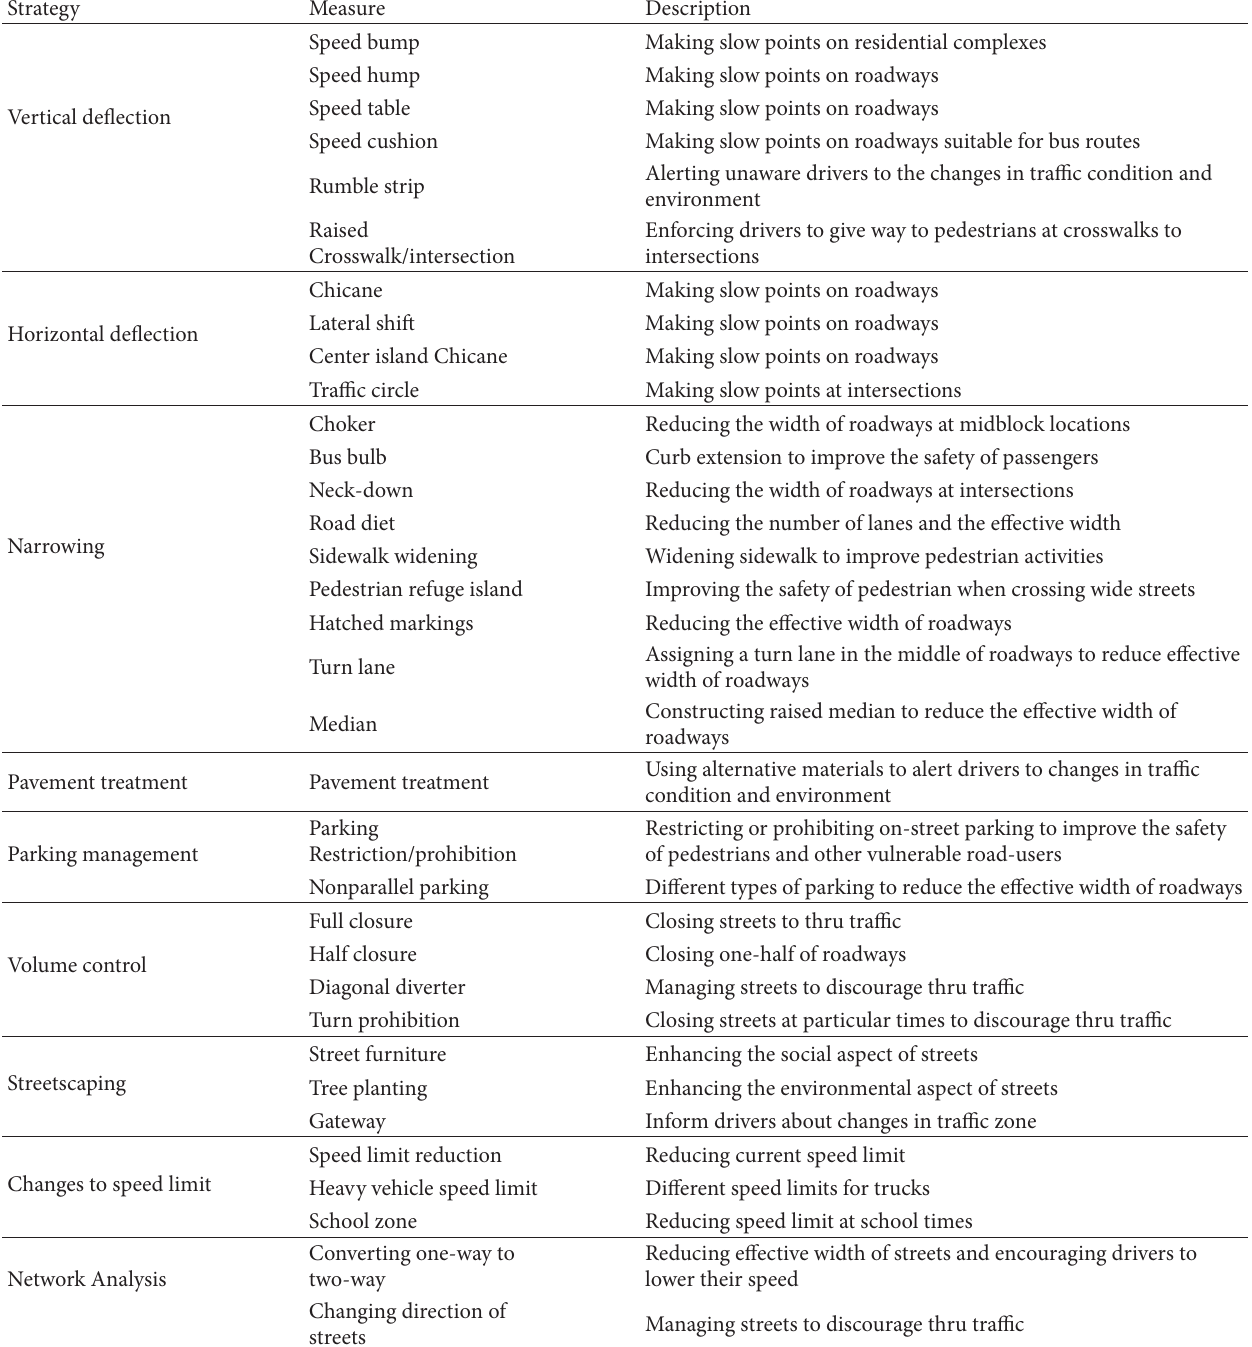
Table 6: A screenshot of the traffic calming strategies